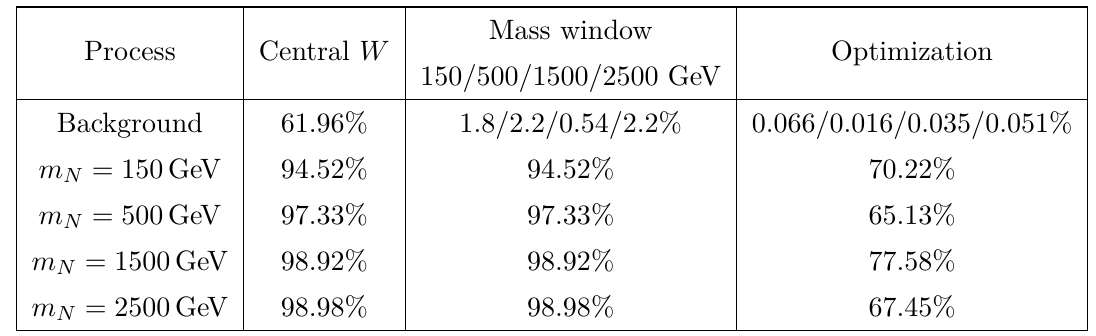
Table 11 . Cutflow table for N e at 3 TeV. All processes after pre-selection are set to